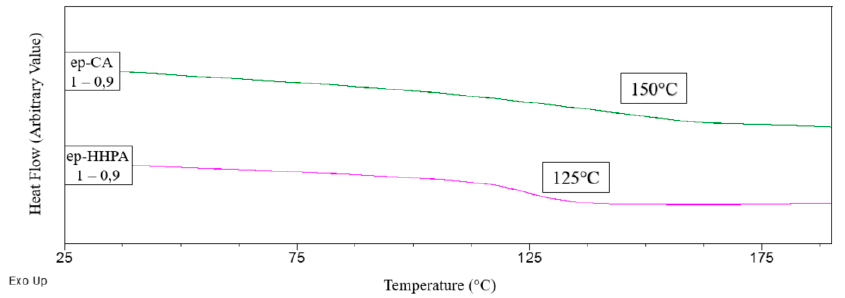
Figure 6. Thermograms comparison for HHPA or CA cured epoxy thermoset (ep / CA / DMID 1 / 0.9 / 0.025). Table 5. Properties comparison for HHPA and CA cured epoxy thermoset (ep / CA / DMID 1 / 0.9 / 0.025). E ′ at 40 °C Max Tan( δ )